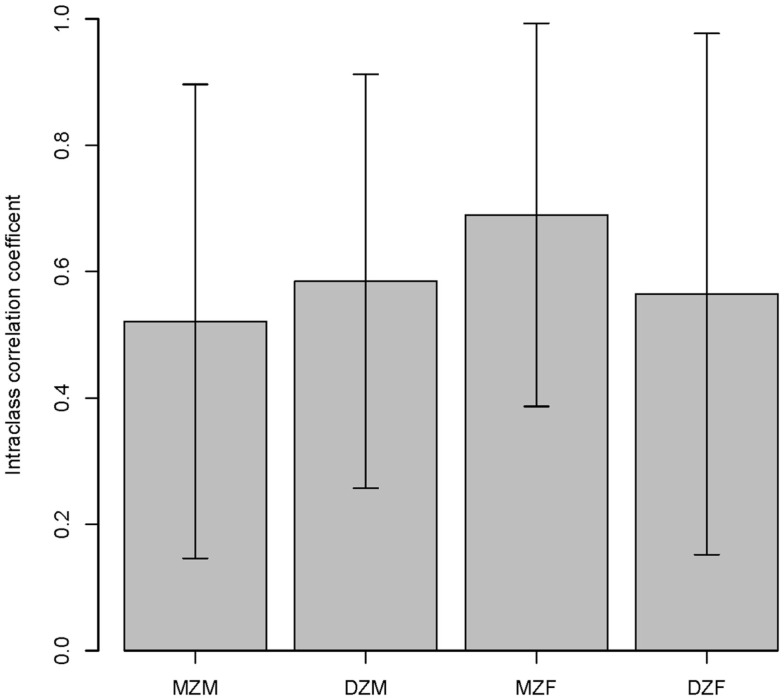
Intraclass correlations within twin pairs are shown. MZM (monozygotic male), DZM (dizygotic male), MZF (monozygotic female), and DZF (dizygotic female).